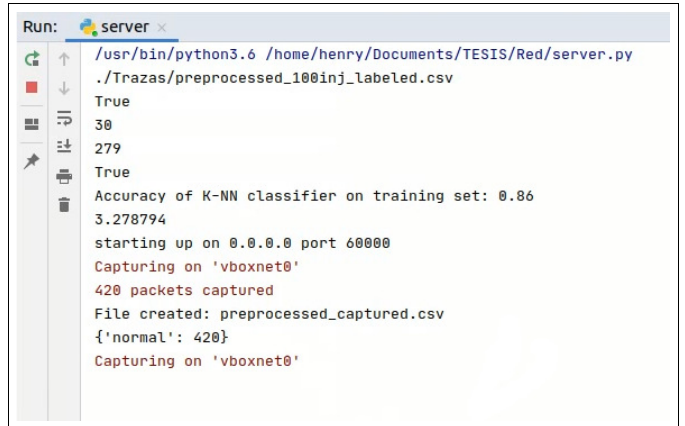
Figure 4. Normal Capture.